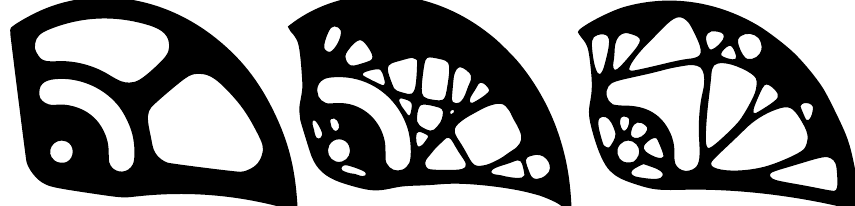
Figure 14. PB6’s cam ( left ), first optimization run ( middle ), optimal cam design ( right